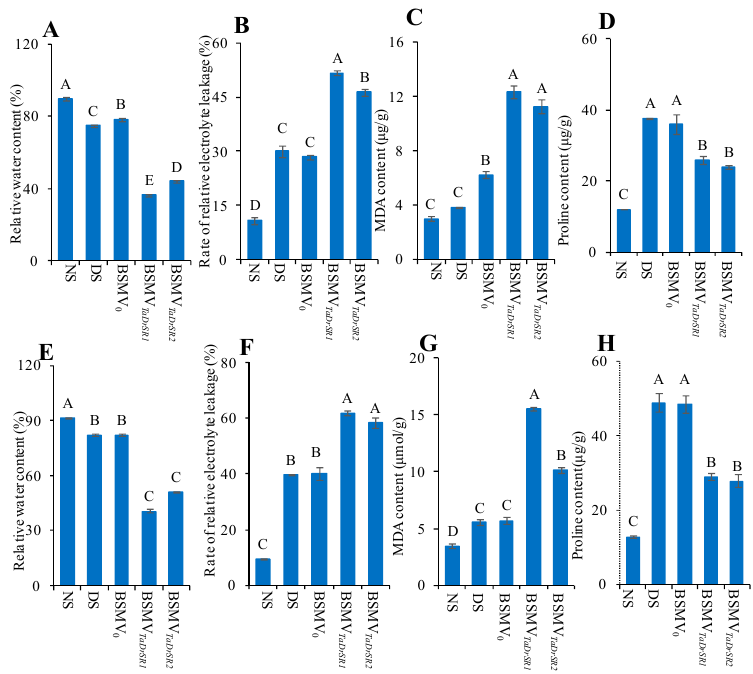
Figure 6. The changes in the physiological indices of the TaDrSR1- and TaDrSR2 -knock-down plants. ( A – D ) XN979 was selected as the receptor for viral infection in the VIGS experiment; ( A ) relative water content; ( B ) rate of relative electrolyte leakage; ( C ) MDA content; ( D ) proline content. ( E – H ) ZM9023 was selected as receptor for viral infection in the VIGS experiment; ( E ) relative water content; ( F ) rate of relative electrolyte leakage; ( G ) MDA content; ( H ) proline content; NS, non-stressed plants; DS, drought-stressed plants; BSMV 0 , negative control of the VIGS system; BSMV TaDrSR1 and BSMV TaDrSR2 , TaDrSR1- and TaDrSR2 -knock-down plants, respectively. Each bar shows the mean ± standard errors (SE) for three biological replicates. Different letters indicate significant differences at P ≤ 0.01 levels.